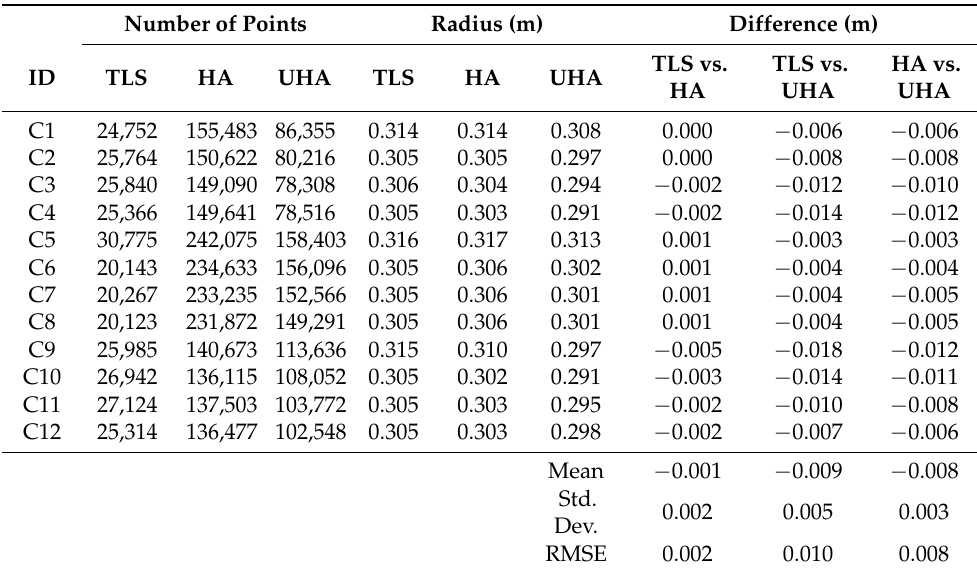
Table 3. Estimated post-registration radii of the cylindrical columns supporting the I-74 bridge from the TLS, PWMMS-HA, and PWMMS-UHA point clouds.